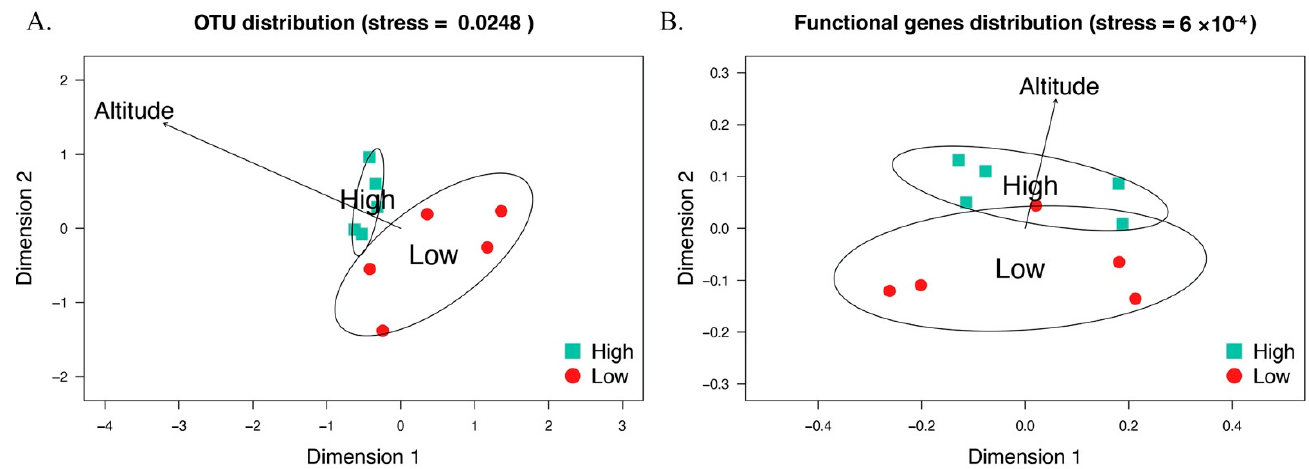
Figure 2. ( A ) Non-metric multidimensional scale (NMDS) plots (based on Bray–Curtis dissimilarity matrix) for bacterial communities. ( B ) NMDS plots (based on Bray–Curtis dissimilarity matrix) for metagenomic functional genes. Statistically significant ( p < 0.05) environmental variable are shown as arrows using permutation tests by envfit function in vegan package R. The color changes of points from red to blue represents the average altitude of forest patches increases from 900 m to 1400